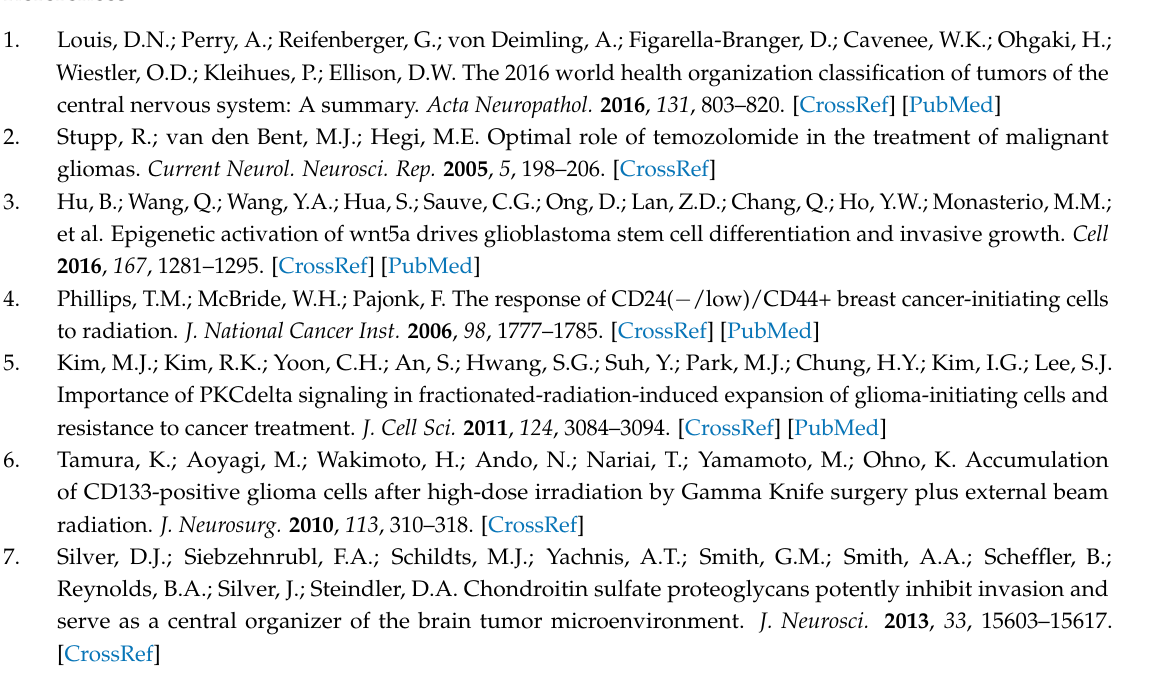
Table S2: The sequences of the primers for quantitative RT-PCR, Table S3: List of proteins tested by antibodies, Table S4: Primers for 6 × RE STAT3 binding sites reporter construction, Table S5: STAT3/Slug axis regulated the tumor-initiating activity of GBM in vivo, Table S6: GBM patients’ description and